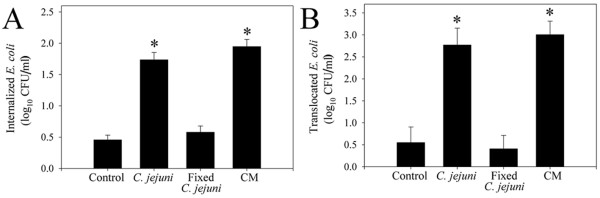
An extracellular product from C. jejuni may induce E. coli translocation. (A) Internalization, and (B) translocation of E. coli HB101 is induced by live C. jejuni 81–176 and conditioned cell culture medium (CM), but not paraformaldehyde-fixed C. jejuni. Data are means ± SEM (n = 3). * P < 0.05 compared to controls.